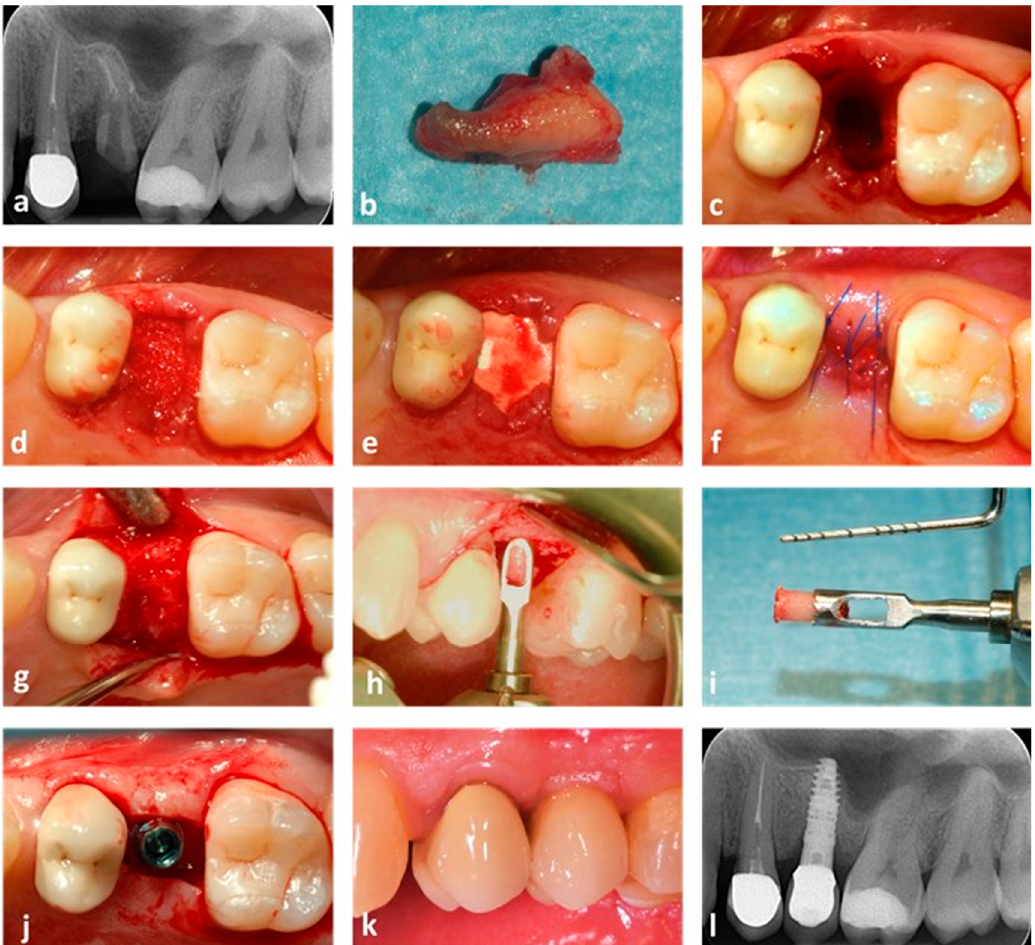
Figure 4. Post-extractive socket grafting. A case where ABB was used is shown. ( a ) X-ray showing the initial patient status. Tooth 25 is fractured and compromised; ( b ) the element after being extracted; ( c ) the post-extractive socket before grafting; ( d ) the socket after being grafted; ( e ) a collagen membrane is placed below the gingival rims to cover the graft; ( f ) single cross stitches stabilize the reconstruction; ( g ) appearance of the regenerated socket 5.3 months after the grafting surgery; ( h ) a bone core is collected using a trephine bur; ( i ) the bone sample after collection; ( j ) an implant (Stone, 3.75 × 14 mm, IDI Evolution, Concorezzo, Italy) is placed into the regenerated bone; ( k ) the final prosthetic rehabilitation; ( l ) one-year control radiograph, showing maintenance of peri-implant bone levels.